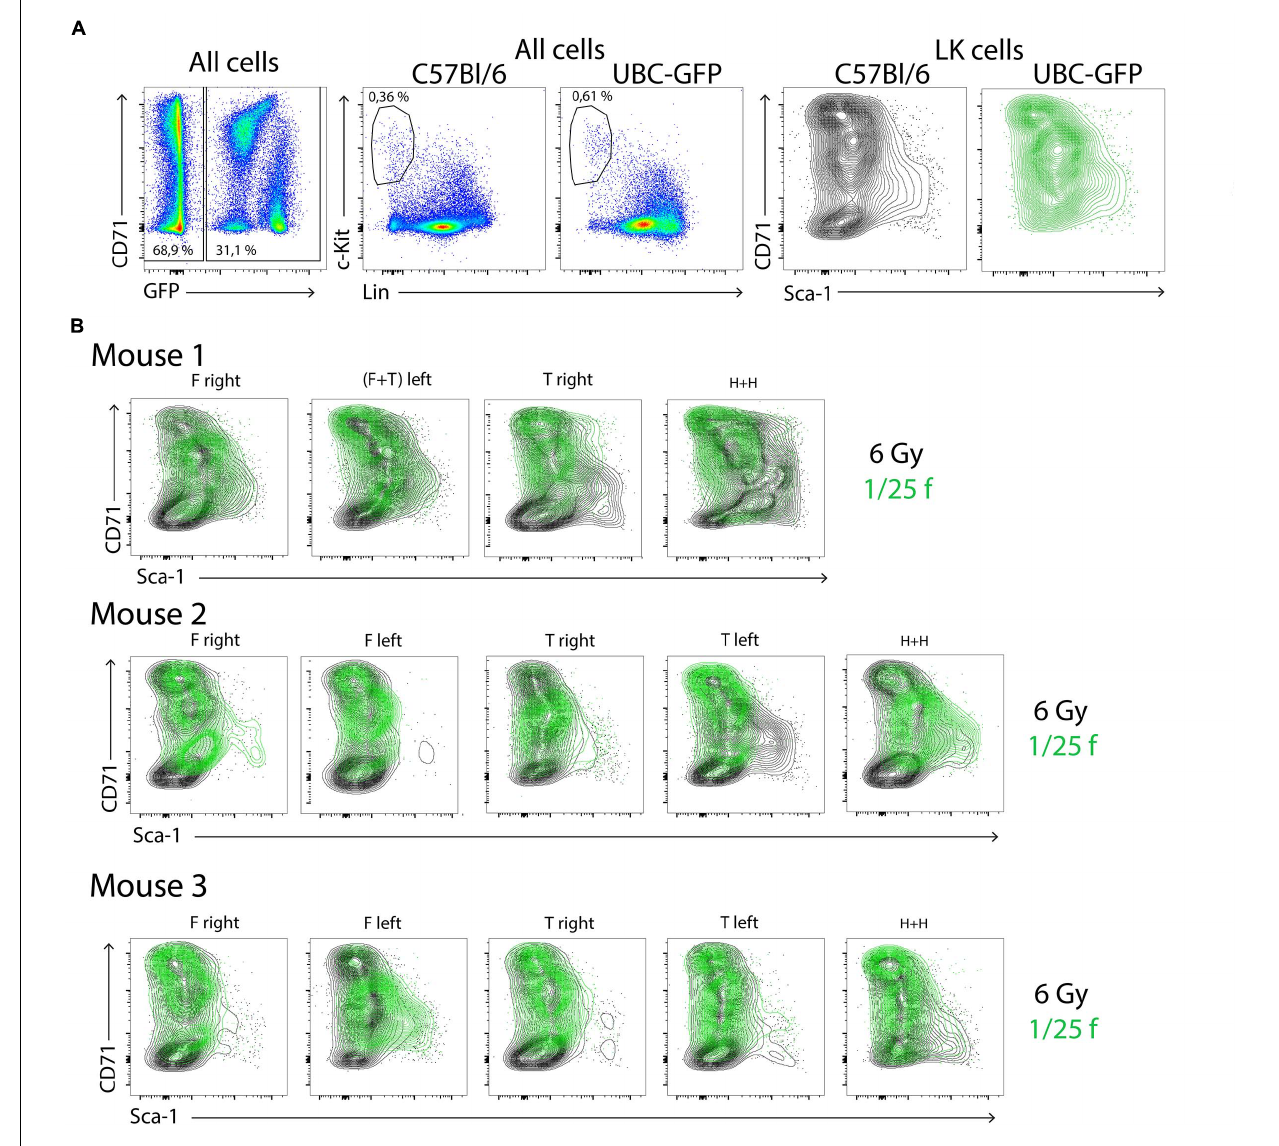
FIGURE 4 | LK cells in chimeric hematopoiesis derived from transplanted and endogenous hematopoiesis reconstituting cells analyzed 2 weeks after irradiation and transplantation. Three C57Bl/6 mice were irradiated at 6 Gy and transplanted with bone marrow of UBC-GFP mice equivalent to 1/25 femur. Bone marrow was collected after 2 weeks separately from the right and left femurs (F), right and left tibias (T), and both humeri (H). (A) Aliquots of 15 bone marrow samples were pooled and analyzed. (B) LK cells in 15 bone marrow samples of three mice are plotted in the CD71/Sca-1 contour diagram; green, LK cells derived from transplanted (1/25 of the femoral bone marrow) bone marrow of UBC-GFP male mice; black, LK cells derived from endogenous hematopoiesis repopulating cells that survived in the 6-Gy-submyeloablative irradiated hematopoiesis of host C57Bl/6 male mice.